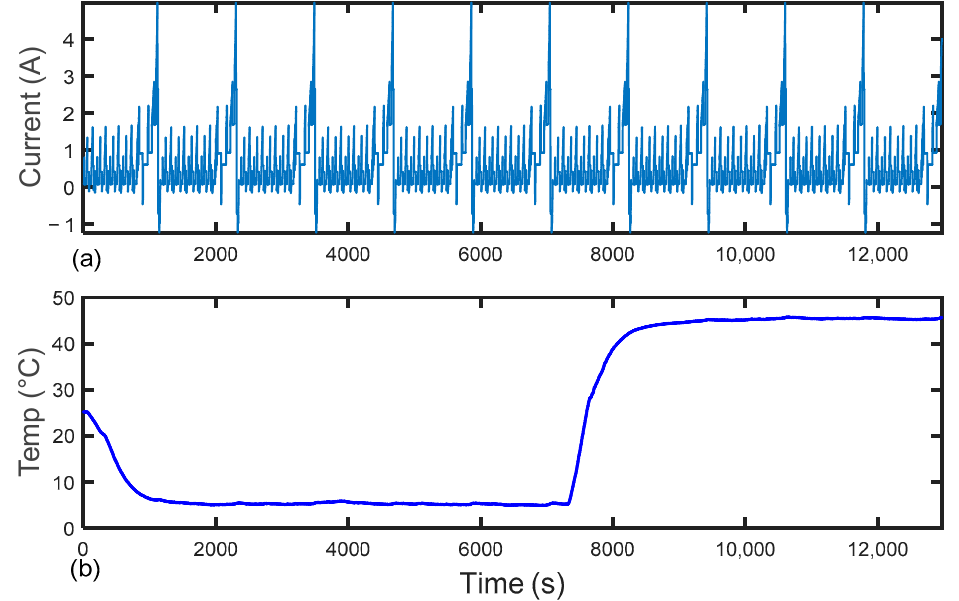
Figure 8. Current and temperature profile of NEDC test under variable temperature: ( a ) current; ( b ) temperature.